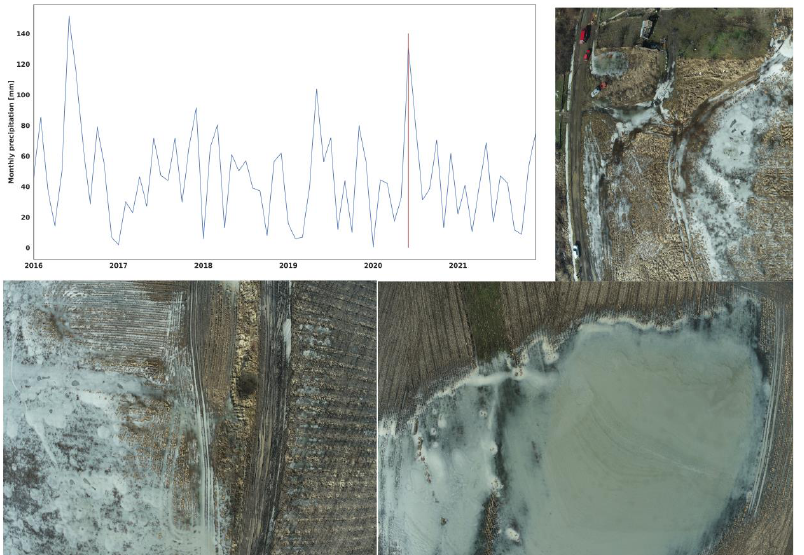
Figure A1. An overview of the investigated field. The graph shows a time series of monthly precipitation from the nearby meteorological station. The red line indicates the recent highest precipitation received at the study site (February 2021). The photo shows waterlogging after a high precipitation event at the study site. Photo captured using a drone DJI camera, model FC6310R on 24 February 2021.